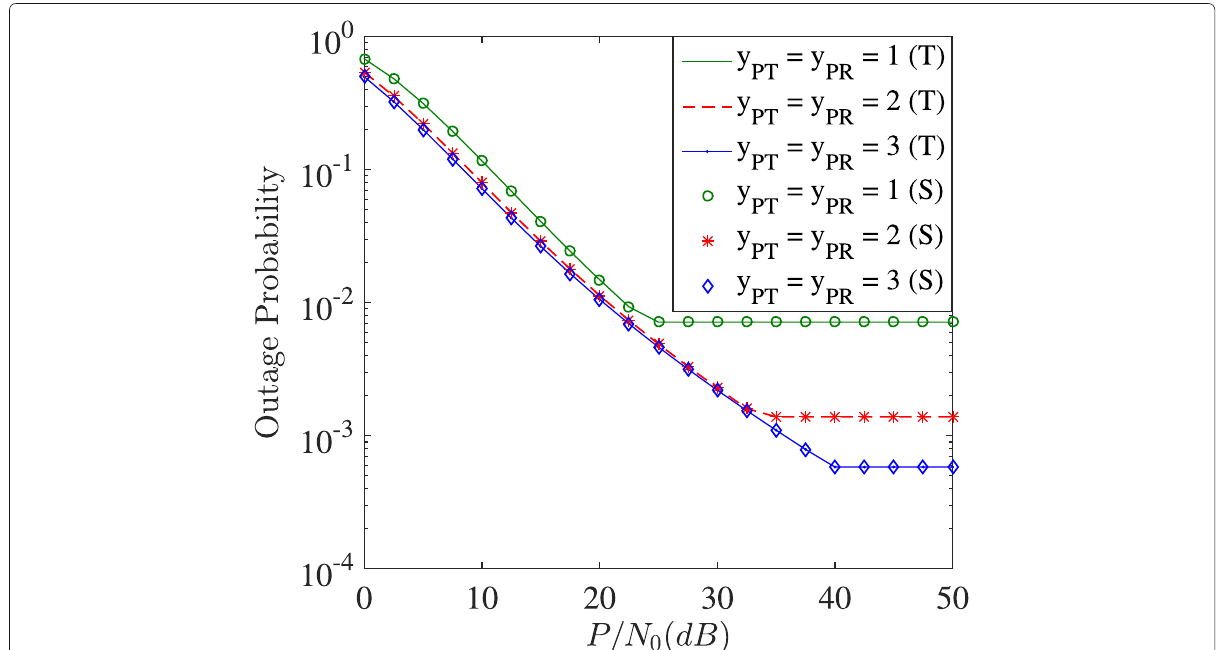
Fig. 13 Outage probability comparison for various y -coordinate locations of PT-PR pair; P PT / N 0 = 10 dB